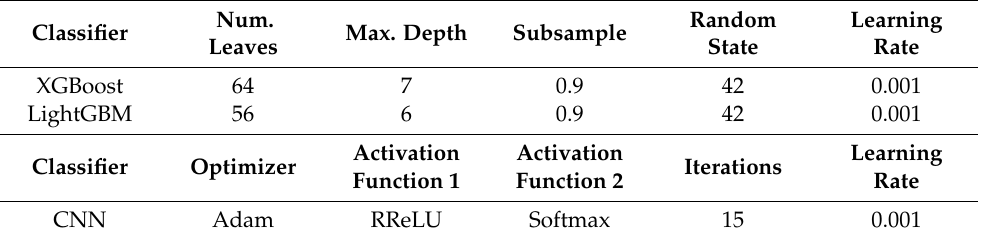
Table 3. The setting of the main hyperparameters of the control group in the experiment.